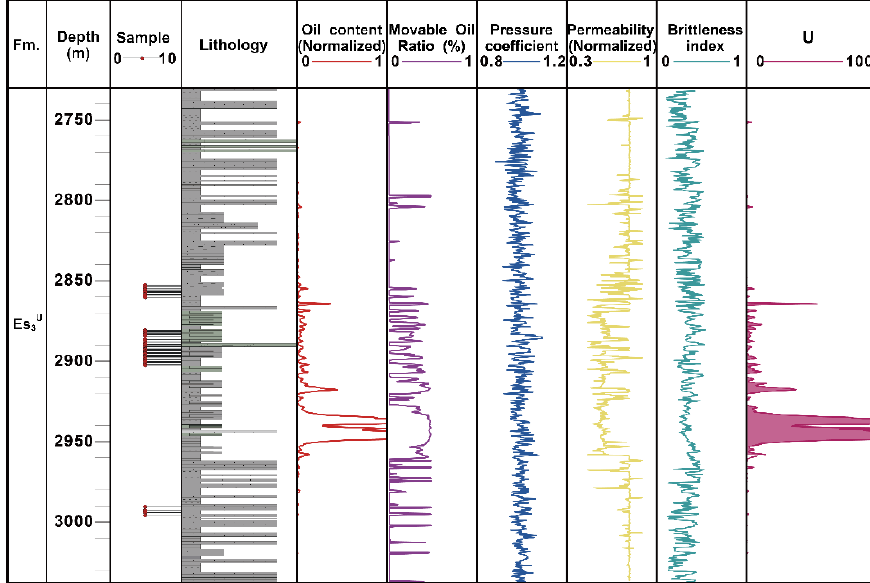
Figure 11. Distribution of the comprehensive weight factor.